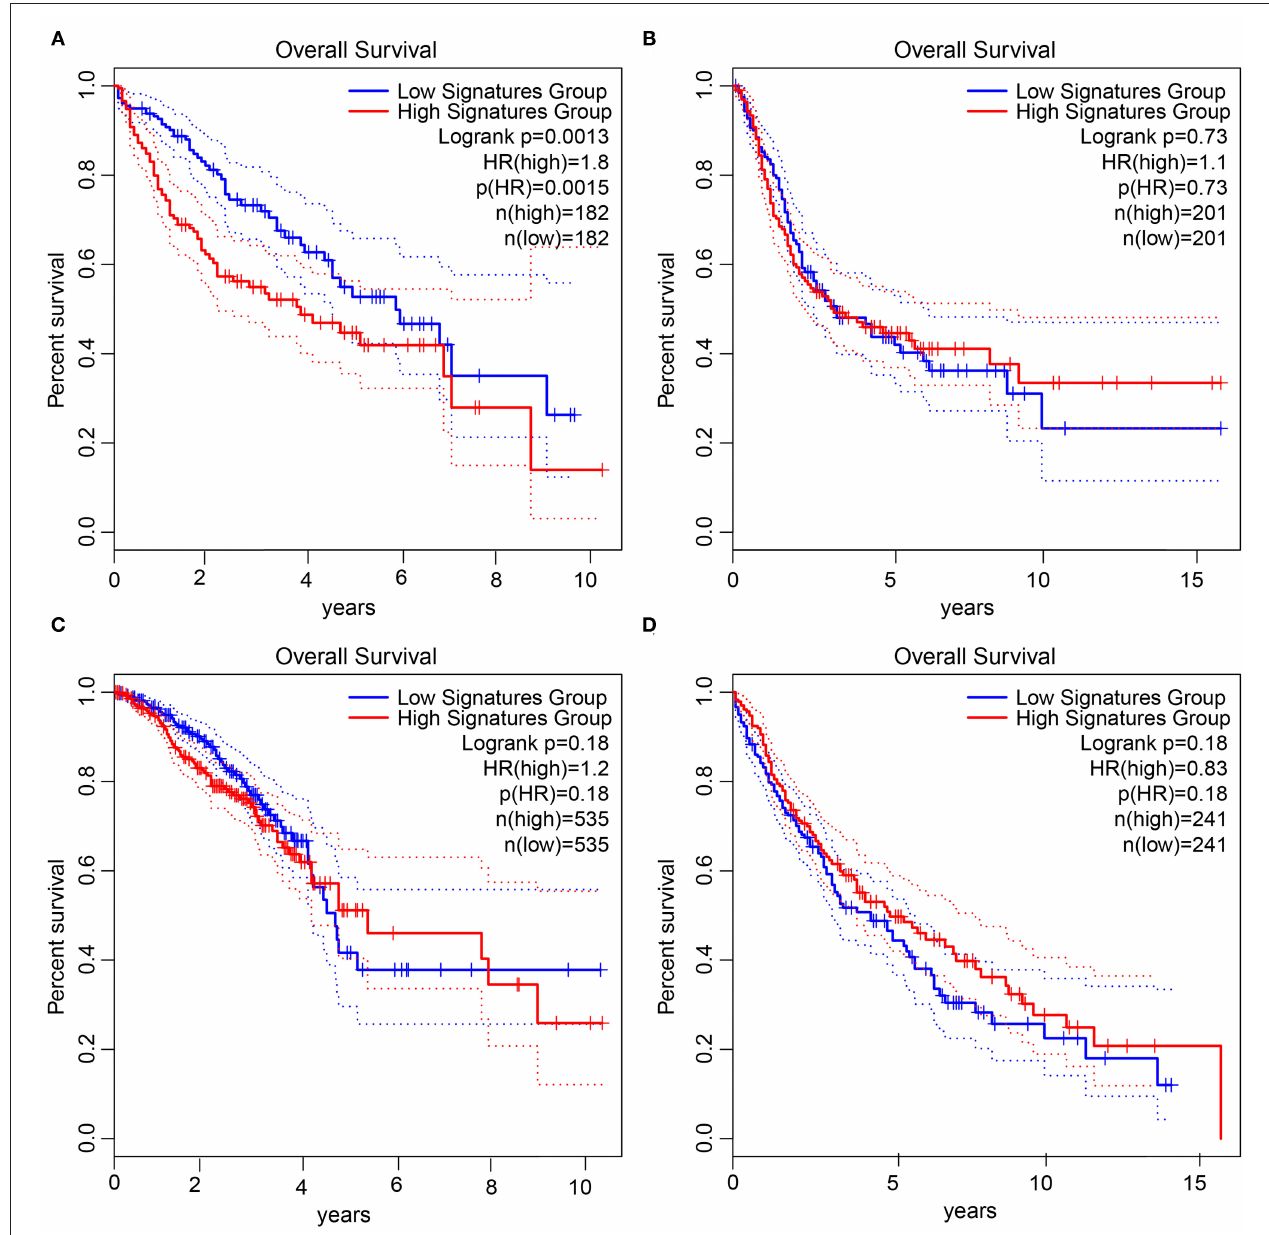
FIGURE 8 | Joint survival analysis of four prognosis-related upregulated gene set in tumors. (A) , Survival status in HCC. (B) , Survival status in bladder urothelial carcinoma. (C) , Survival status in breast invasive carcinoma. (D) , Survival status in lung squamous cell carcinoma. The X-axis represents the survival time in months, and the Y-axis represents the survival rate. The upper right corner shows the color code, p value, sample information, etc. The red line is the high gene expression group, the blue line is the low gene expression group, and the dotted line is the 95% confidence interval